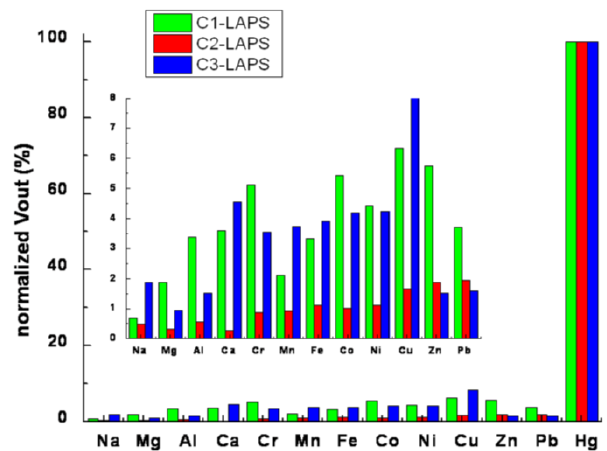
Figure 5. The response of Ci-LAPS (i = 1, 2, 3) to other metal ions and the comparison with Hg 2+ .